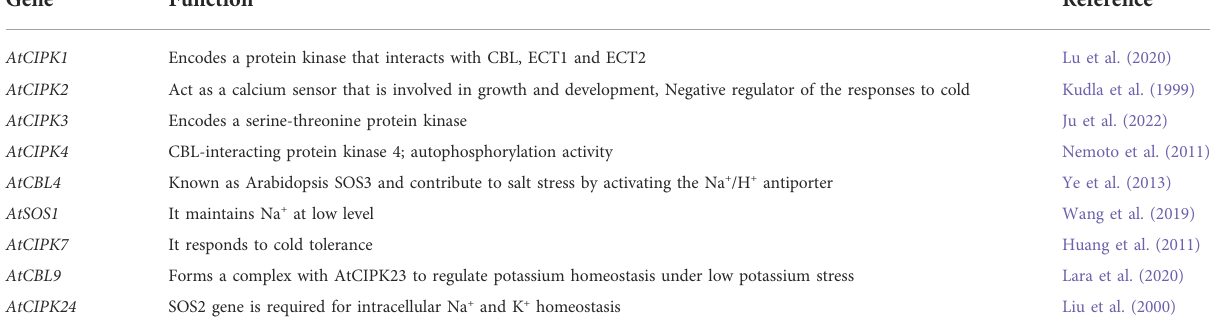
TABLE 2 CIPK genes and their function in Arabidopsis thaliana . Gene